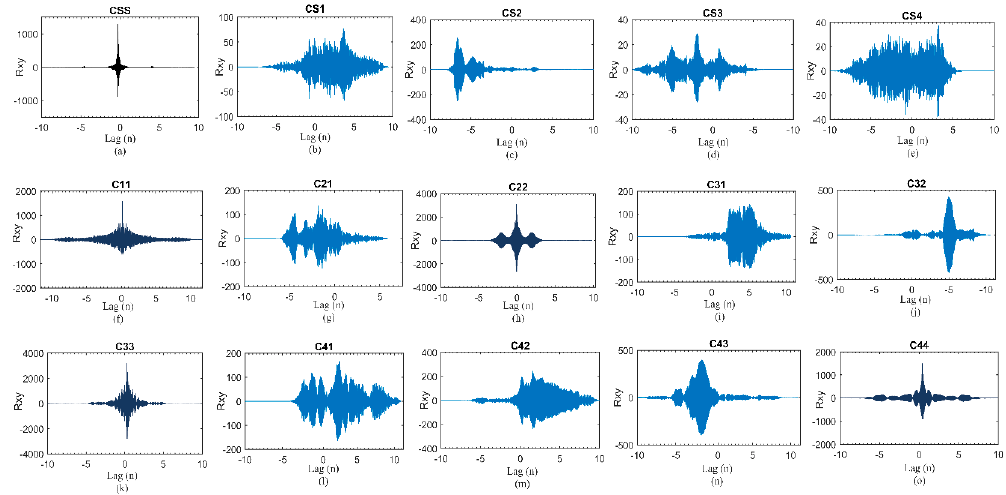
Figure 4. Correlation between synchronization signal and bionic Morse elements.